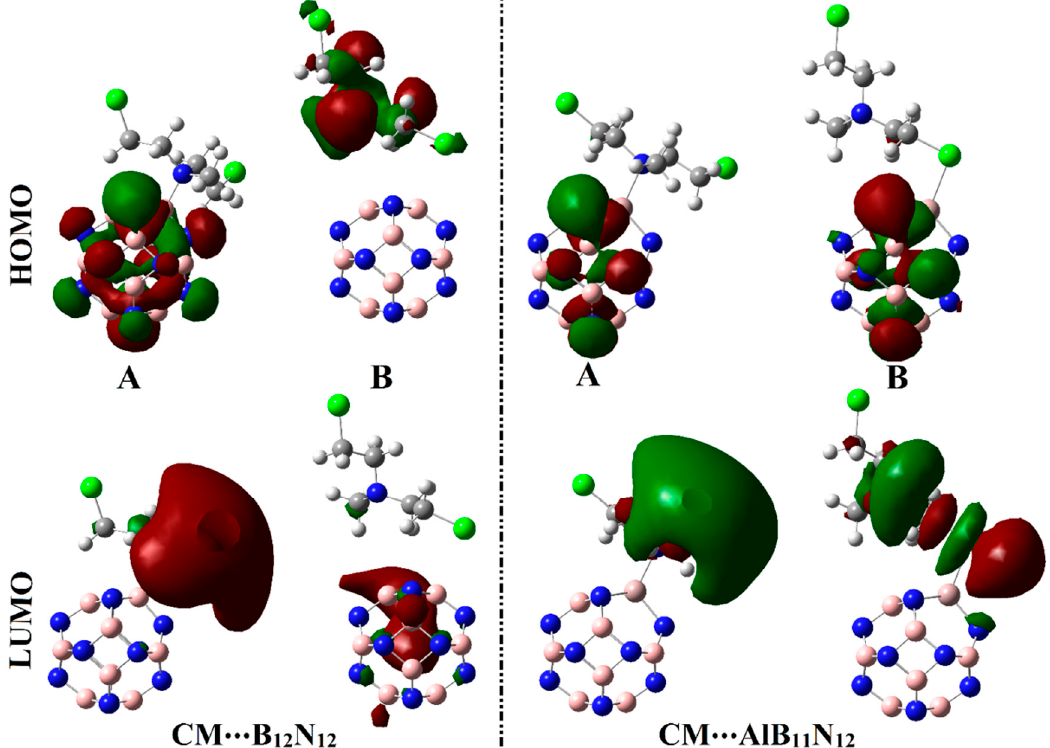
Figure 7. Diagrams of HOMO and LUMO distributions of the optimized CM ∙∙∙ B 12 N 12 and ∙∙∙ AlB 11 N 12 complexes within configurations A and B.